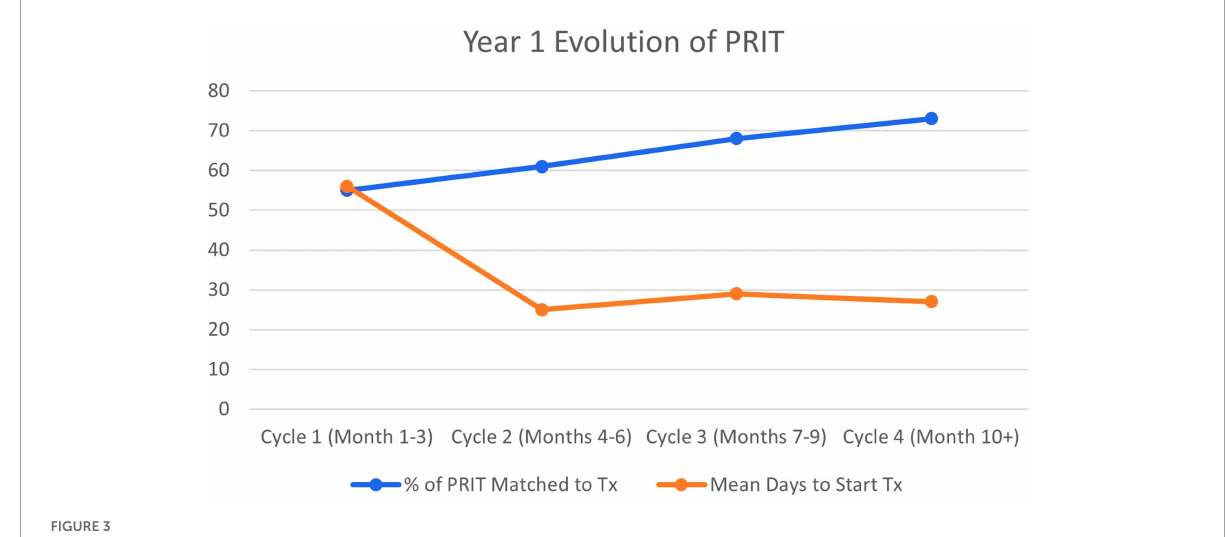
FIGURE3 Percentage of psychology rapid intake team (PRIT) referrals matched for treatment and average days for patients to start treatment. Tx, treatment.